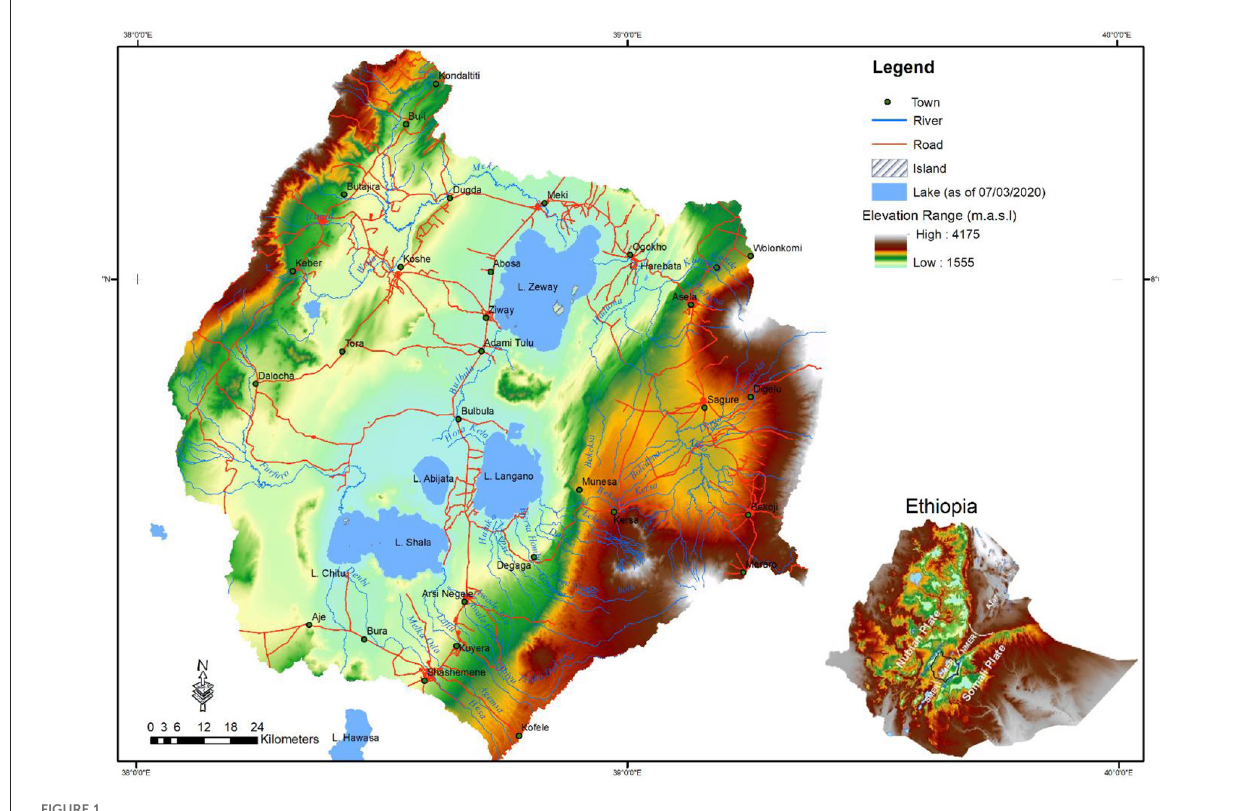
FIGURE1 Location map of the Central Rift Valley.